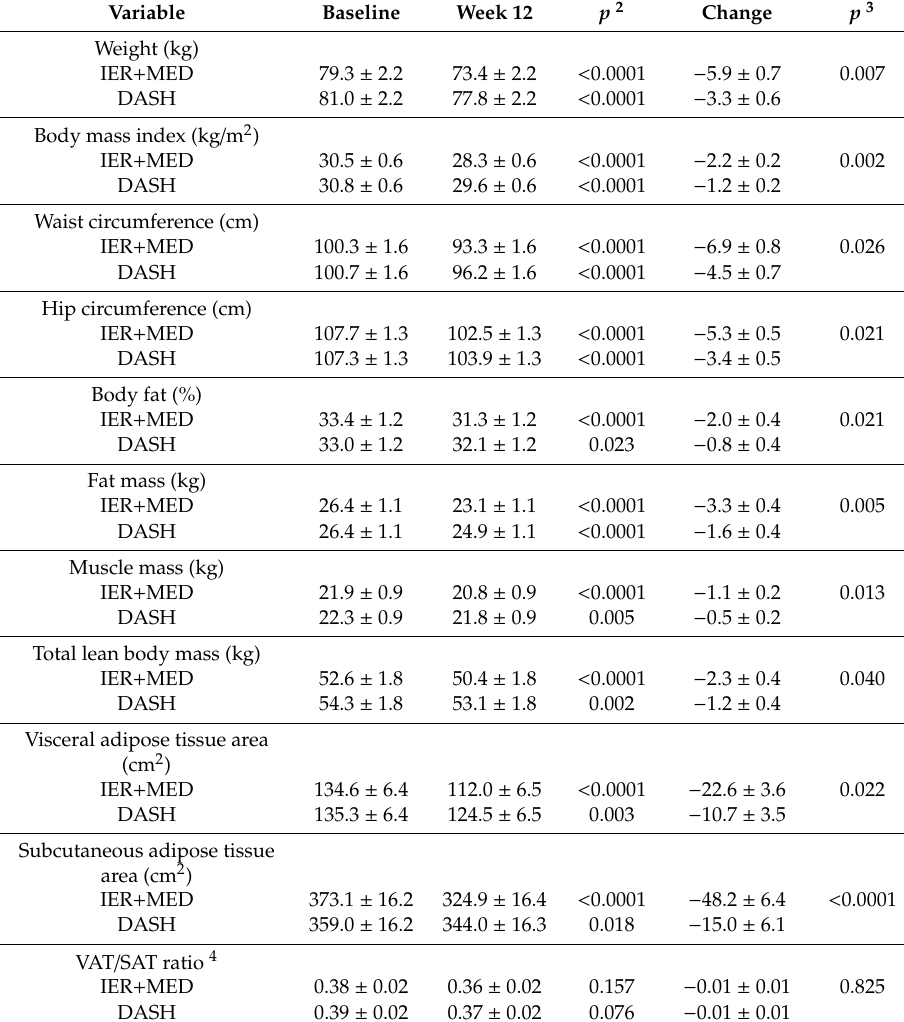
Table 3. Baseline, Week 12, and change in anthropometric measures within and between the IER + MED group ( n = 30) and DASH group ( n = 30) 1